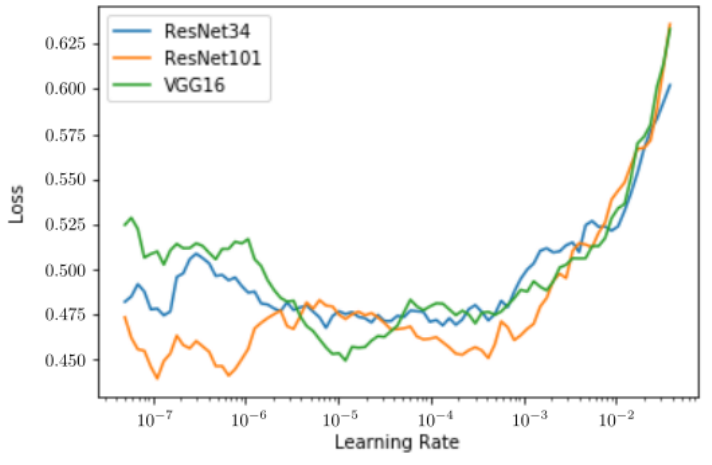
Figure 8. Learning rate range tests for models used in this